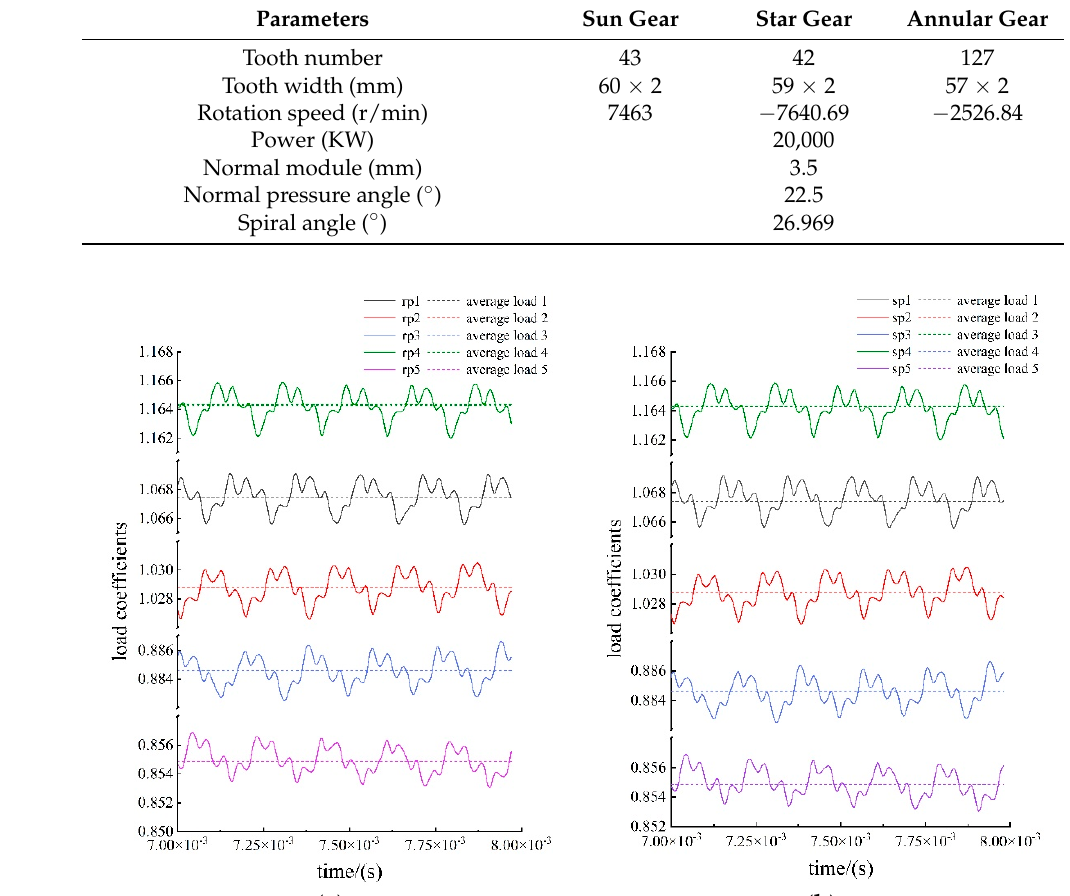
Table 1. Basic parameters of herringbone tooth star gear train in a GTF.